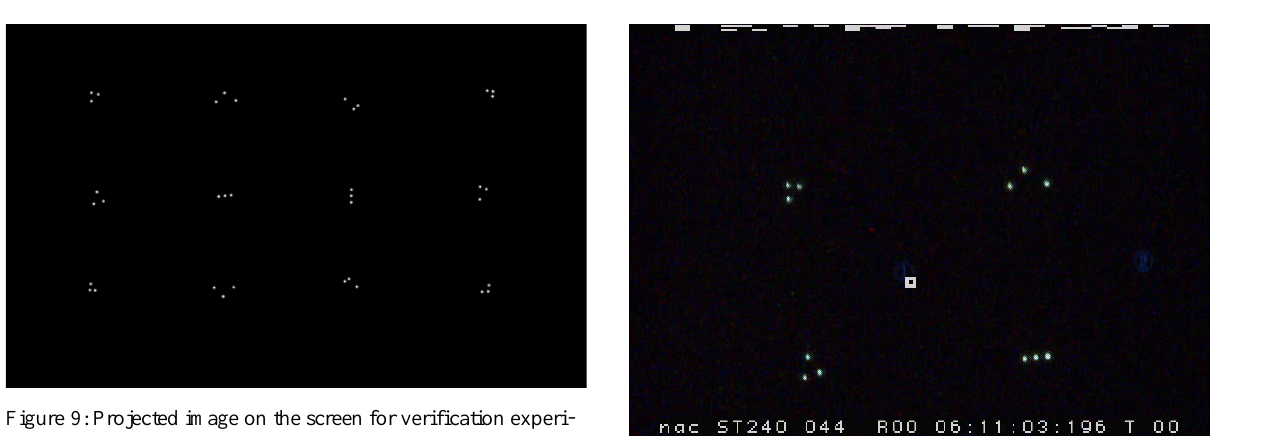
Figure 9: Projected image on the screen for verification experi- ment.